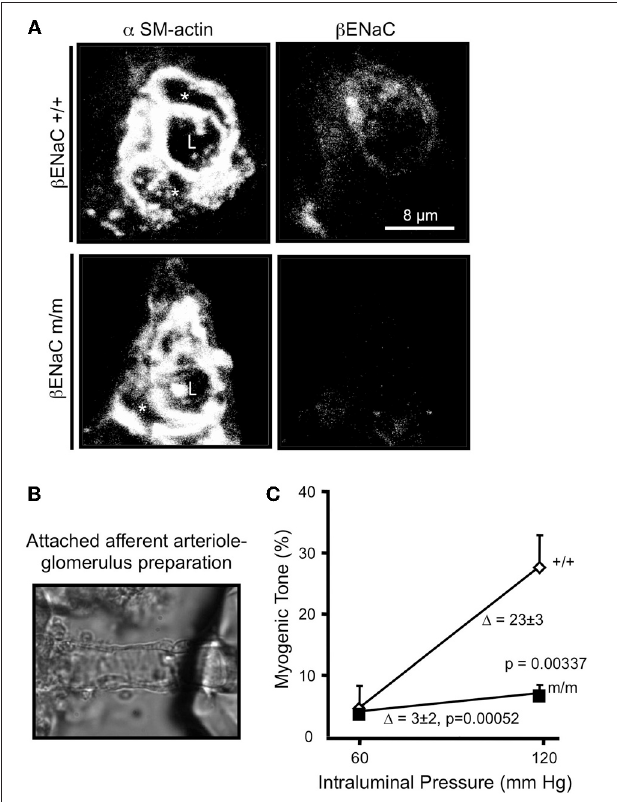
FIGURE 4 | Localization of β ENaC and contribution to myogenic constriction in renal afferent arteriole. (A) Localization of SM α -actin (left) and β ENaC (right) in a cross-sectional image of a renal arteriole from a β ENaC + / + (top) and m/m (bottom) mouse. In the merged image, an “L” identifies the arteriolar lumen and an asterisk ( ∗ ) identifies the VSMC cell bodies. (B) Image of an isolated afferent arteriole with attached glomerulus preparation. (C) Steady state vasoconstrictor responses to an increase in pressure in afferent arterioles in β ENaC + / + and m/m animals ( n = 6). Vasoconstrictor responses to adrenergic agonist norepinephrine (NE) were similar (not shown). (Figure reproduced from American Journal